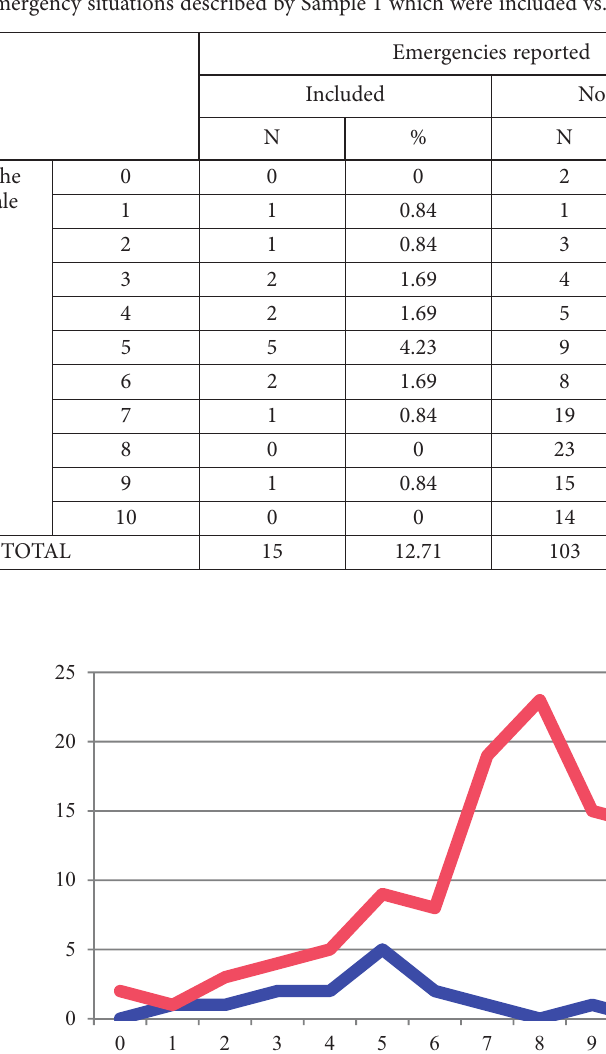
Table 2. Emergency situations described by Sample 1 which were included vs. not included in the aircraft operation checklists